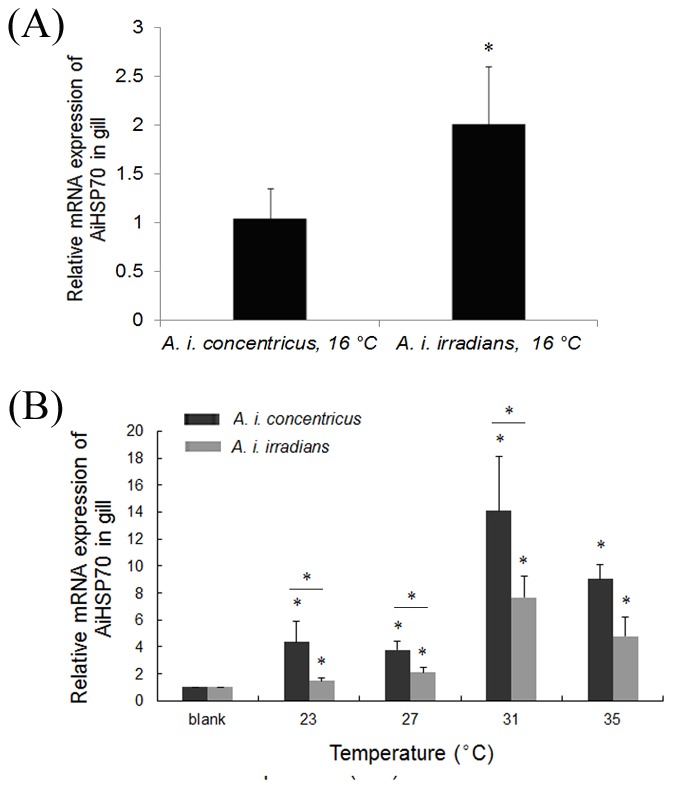
Temporal expression of AiHSP70 mRNA in bay scallop A. i irradians and A. i. concentricus relative to β-actin in gills under normal physiological condition (A) and after acute heat stress treatment (B) as measured by RT-PCR.Vertical bars represent the mean ± S.E. (N = 5). (*: P<0.05).